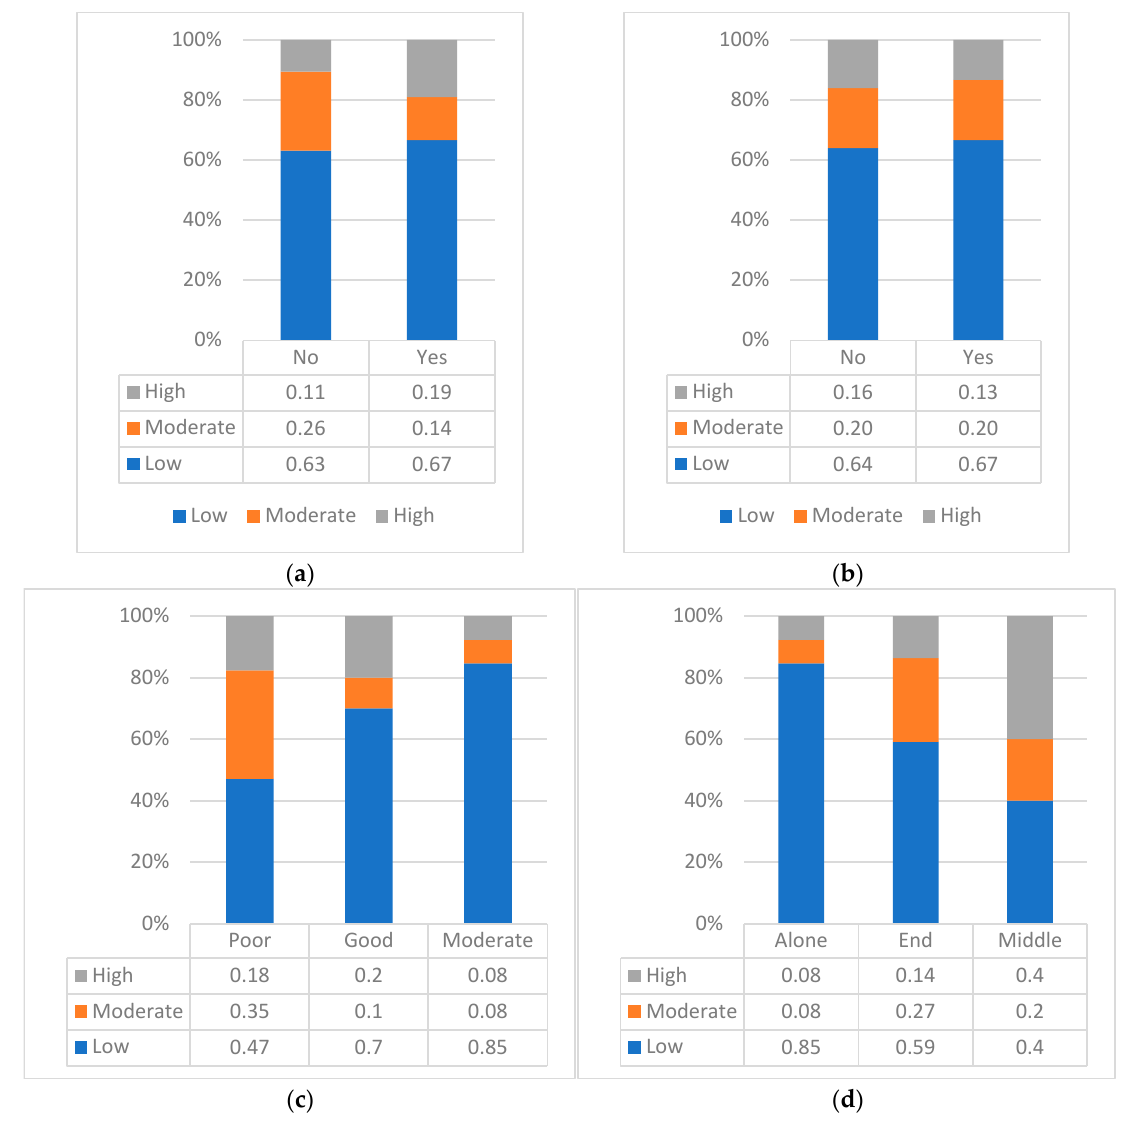
Figure 13. Building damage state relation with ( a ) vertical irregularity, ( b ) plan irregularity, ( c ) con- struction quality, and ( d ) structural system.